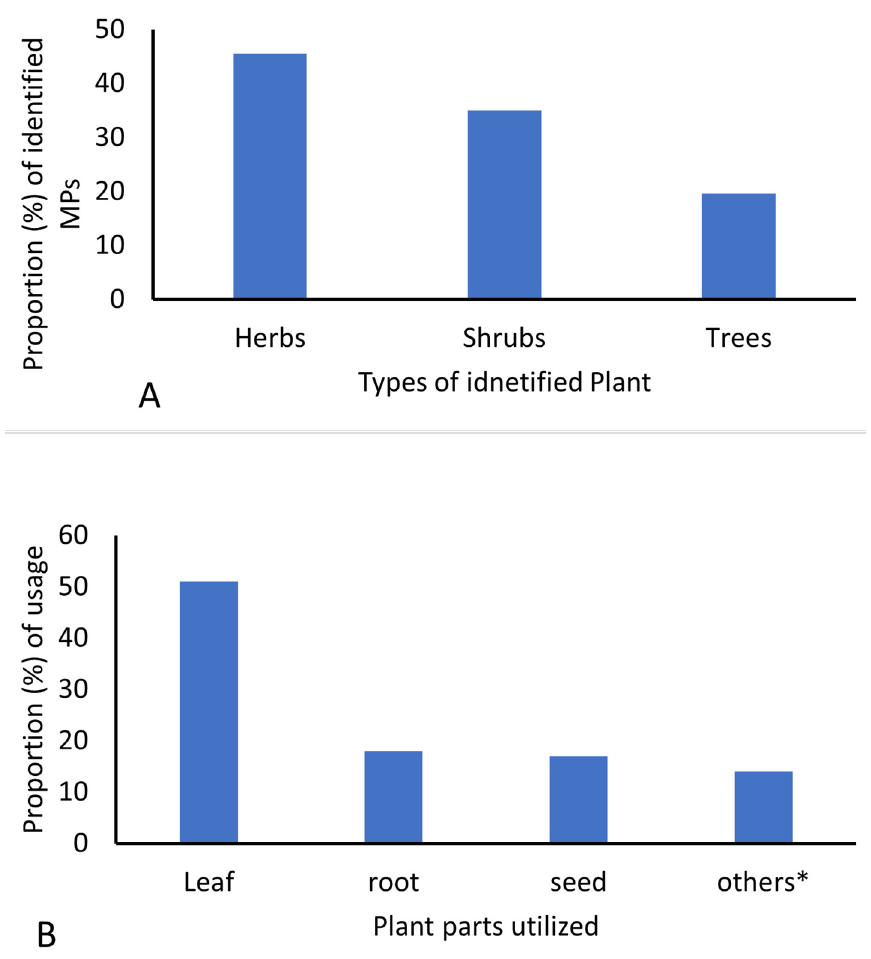
Figure 2. ( A ) Forms of identified MPs. ( B ) Plant parts and the proportion used in the preparation of herbal remedies. Others* include barks, bulbs, clade, flowers, fluid and